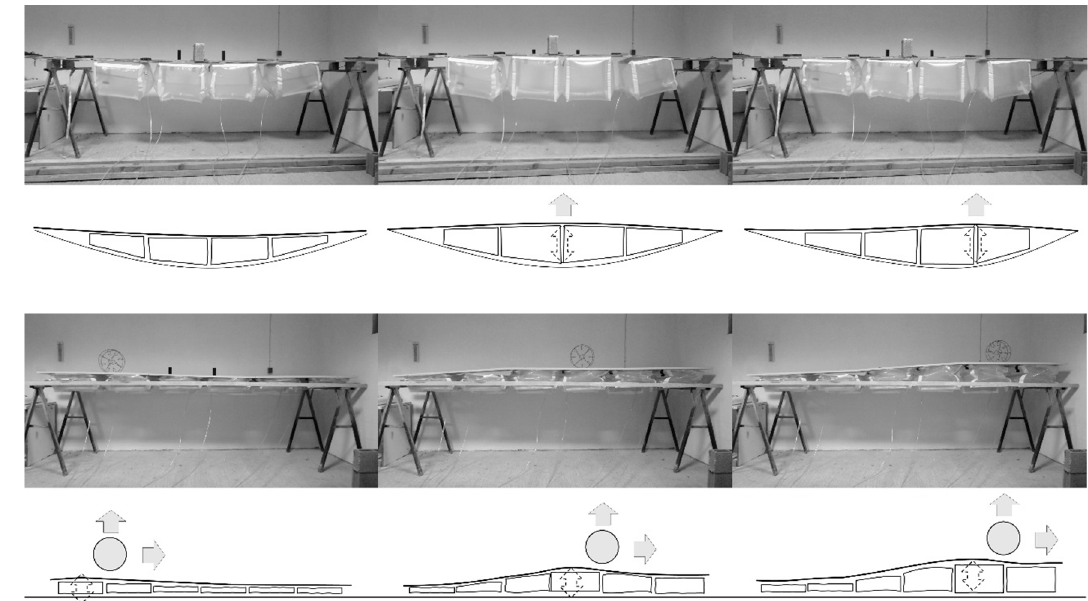
Figure 8. Basic body plan type C3: ( a ) Tensairity-like beam; ( b ) Morphodynamic ramp.